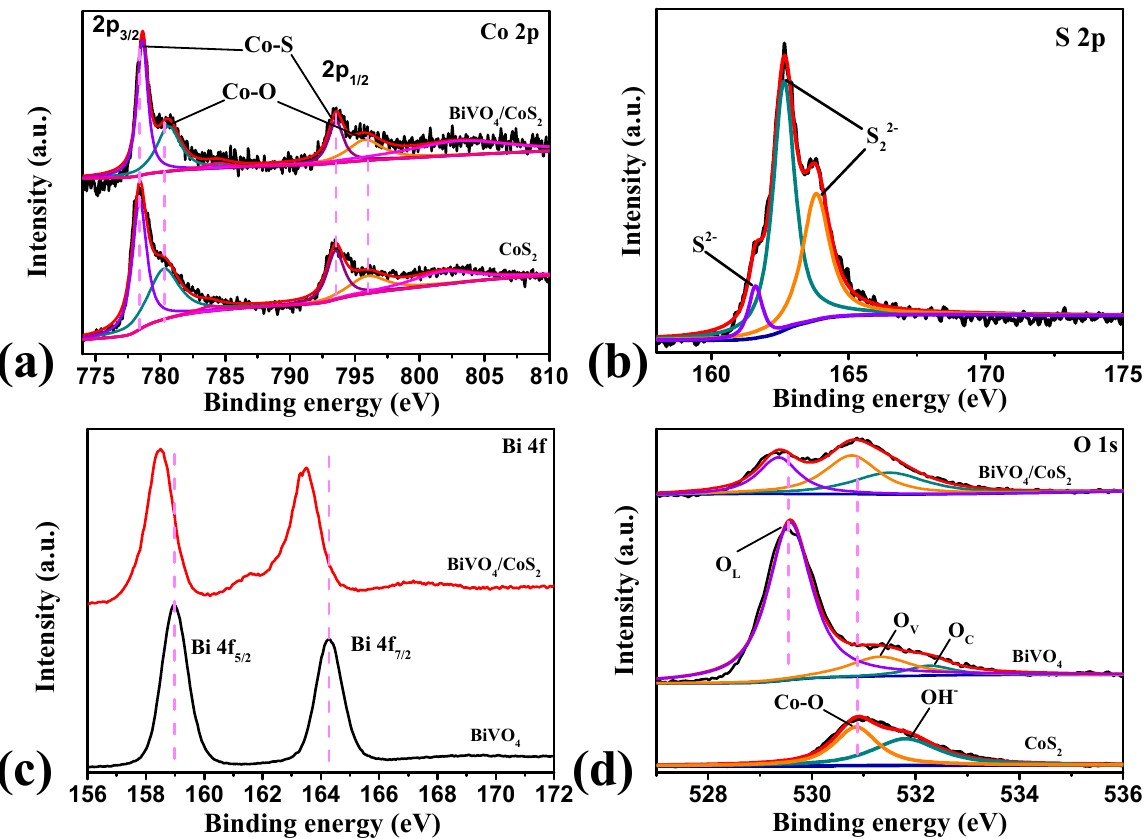
Figure 2. XPS spectra of the bare BiVO 4 , CoS 2 , and BiVO 4 /CoS 2 samples. ( a ) Co 2p, ( b ) S 2p, ( c ) Bi 4f, and ( d ) O 1s.